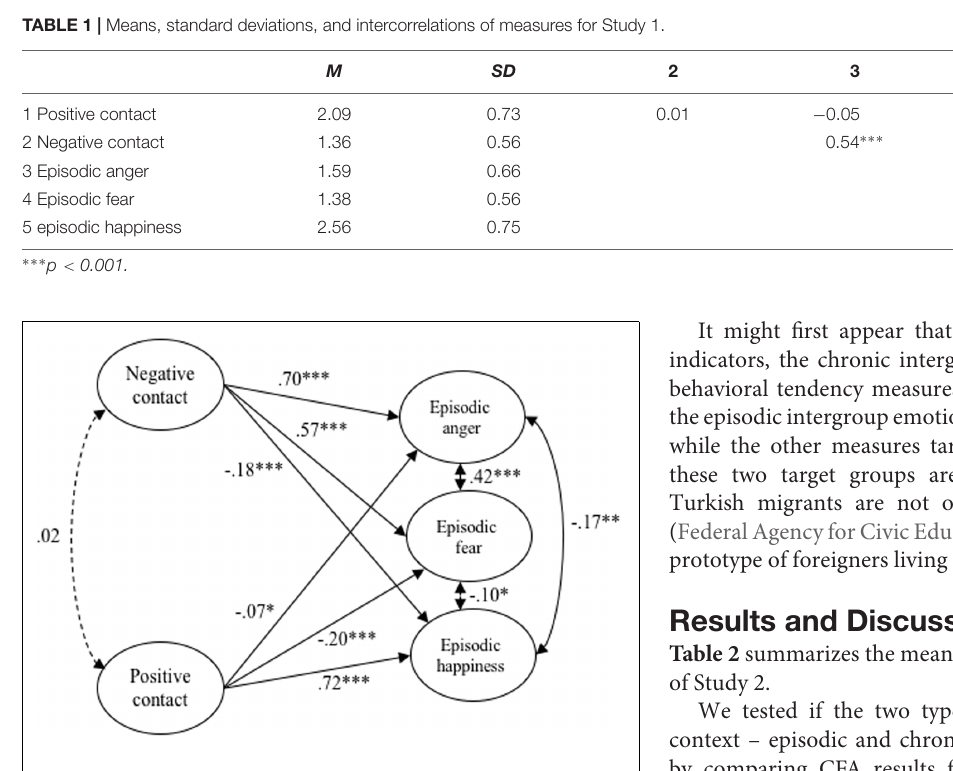
FIGURE 2 | Structural equation model tested in Study 2. ∗∗∗ p < 0.001, ∗∗ p < 0.01, ∗ p < 0.05; standardized coefficients are shown. Continuous arrows indicate significant, and dashed arrows non-significant, relationships. Double-headed arrows indicate correlations. Indicator variables of latent variables and error variances are not included for simplicity; ( χ 2 = 65.13; df = 25; p < 0.001; CFI = 0.988; RMSEA = 0.034; SRMR = 0.021).